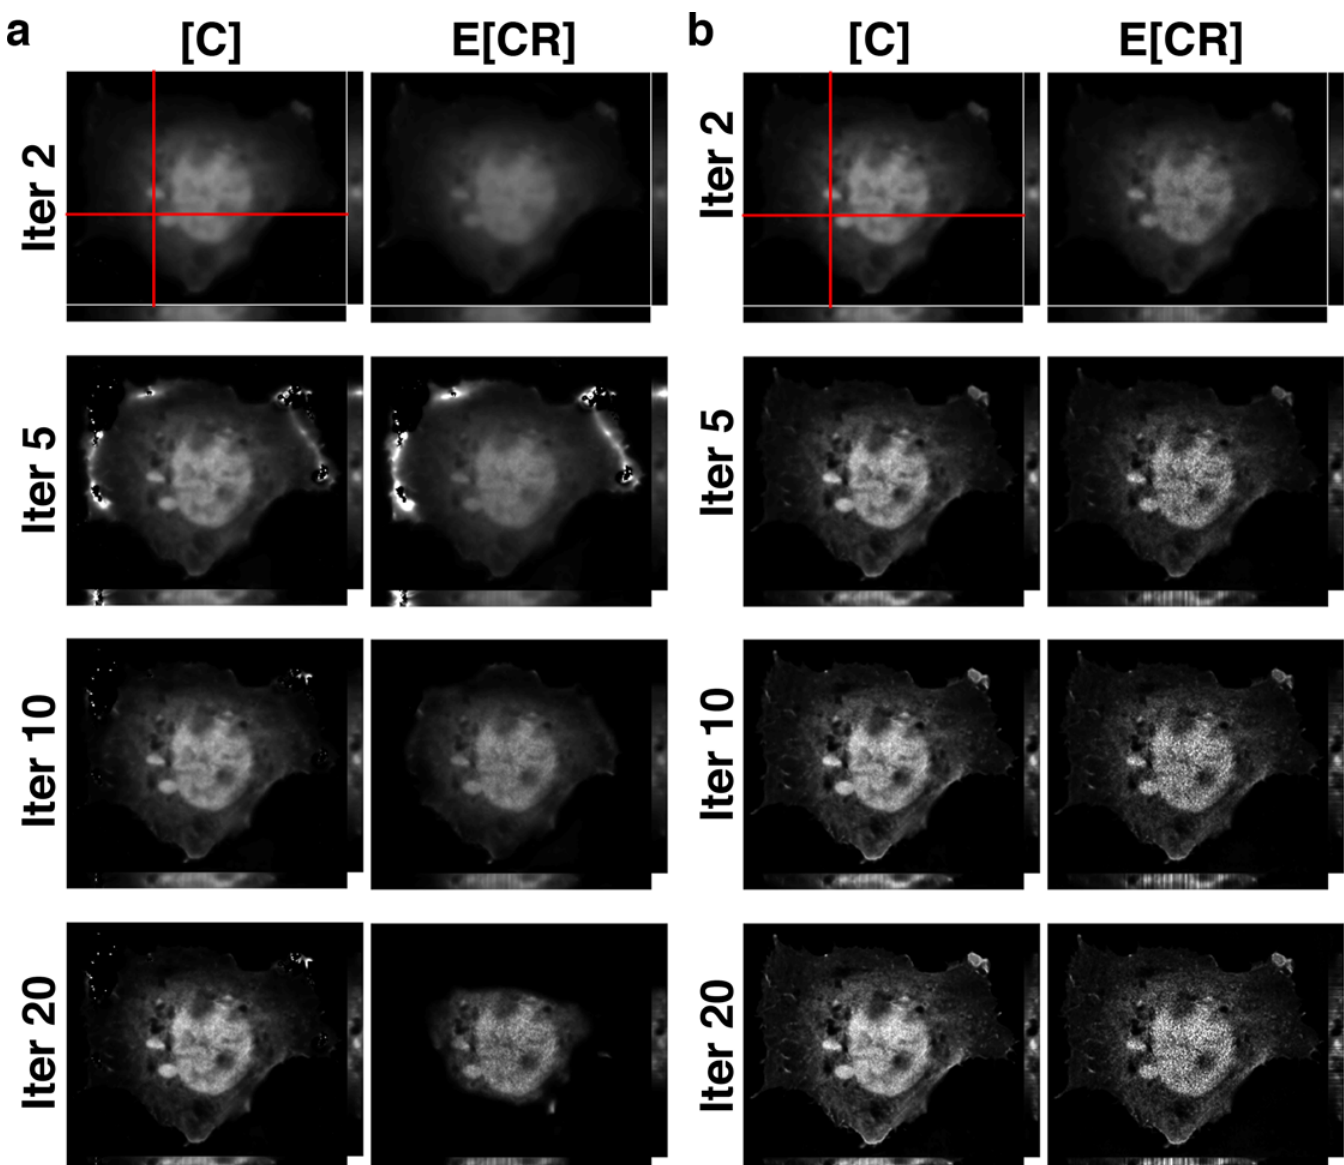
Fig 2. The modified algorithm (3D-3Way FRET) recovers total concentrations and apparent FRET efficiencies for linked fluorophores. (a) Cos7 cells expressing the triple linked construct RFP-CFP-YFP were imaged and reconstructed with 20 iterations of the original 3DFSR algorithm (only [C] and E[CR] are shown for clarity). Note that the E[CR] signal at the margin of the cell erodes away, until only the bright nucleus region remains. (b) The revised 3D-3Way FRET algorithm, properly reconstructs the images without the erosion that was evident in a.